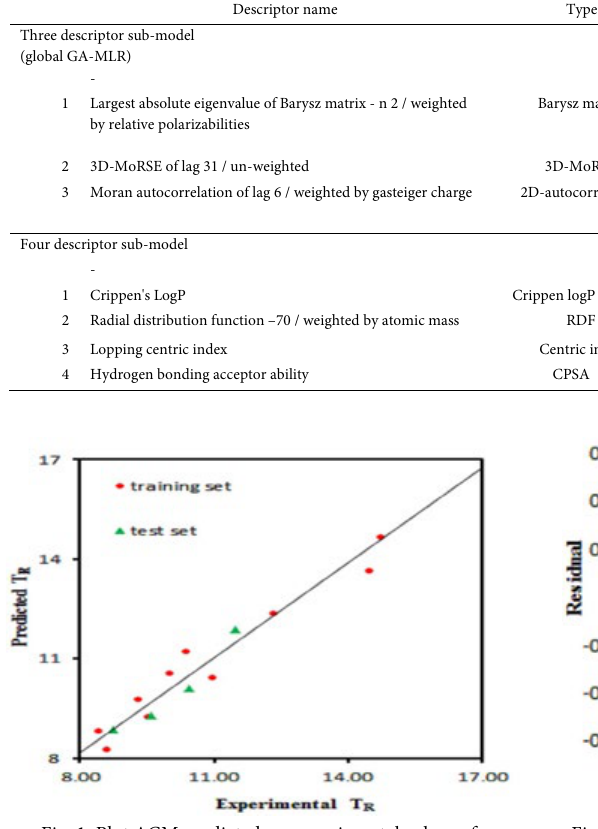
Fig. 2. Residuals of ACM predicted vs. experimental values of retention time.